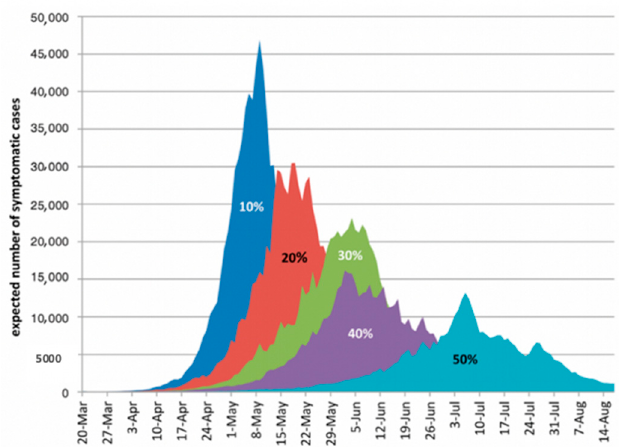
Figure 7. Expected symptomatic COVID-19 cases in a 5-month quarantine period.